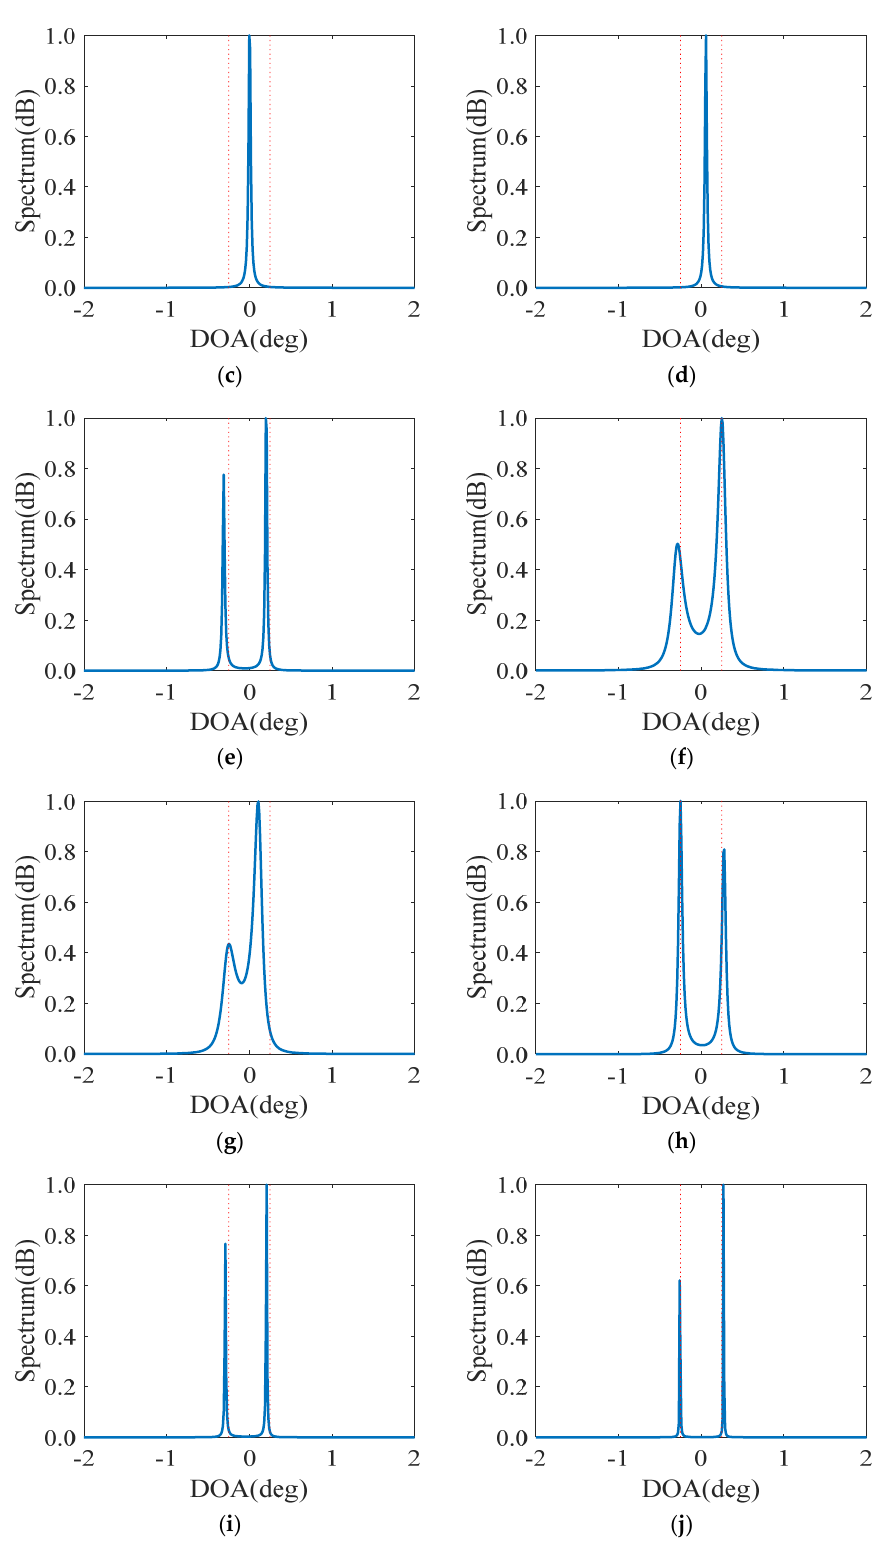
Figure 6. Comparison of resolution, where K = 2, SNR = 0 dB and N p = 100. The blue solid line and the red dashed line represent the estimation results and the actual angels, respectively. ( a ) NA- DCA; ( b ) CPA-DCA; ( c ) GNA-DCA ( α = 5, β = 6); ( d ) CPA-DSCA; ( e ) DsNA; ( f ) INAwSDCA − I; ( g ) INAwSDCA − II; ( h ) GNA-DSCA ( α = 1, β = 11); ( i ) GNA-DSCA ( α = 5, β = 6); ( j ) GNA-DSCA ( α = 5, β =